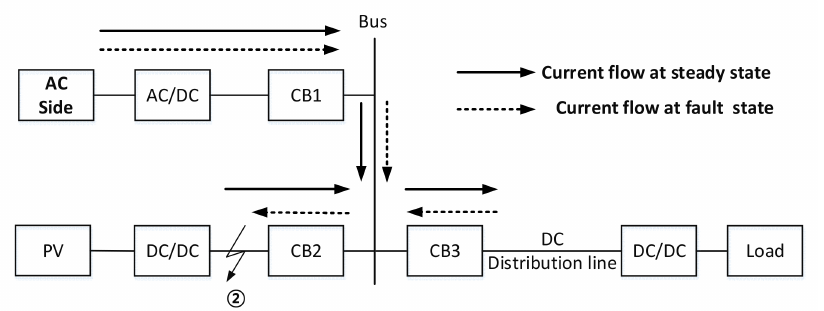
Figure 3. Comparison of the current flow in the steady state and in a fault in section 2 (cid:13) .